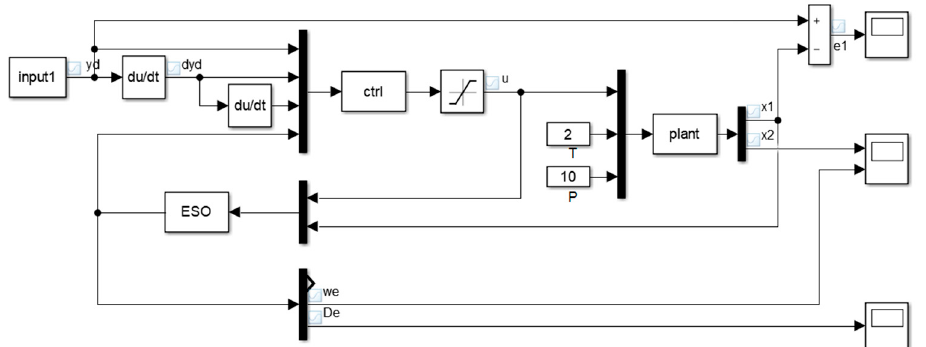
Figure 3. Simulation model of the electric oil-filled joint actuator. Table 1. The nominal parameters of the electric oil-filled joint actuator.